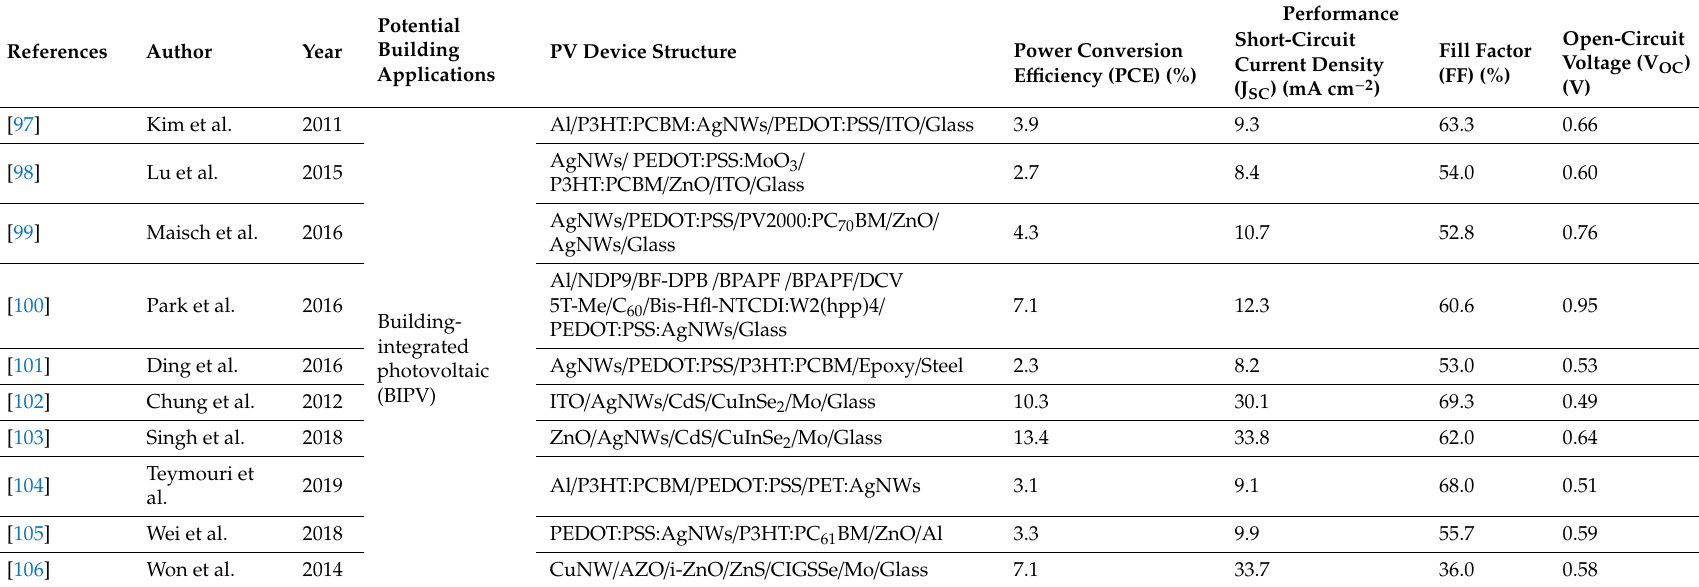
Table 5. Summary of AgNWs and CuNWs for fabricating TCE used in Photovoltaic (PV)